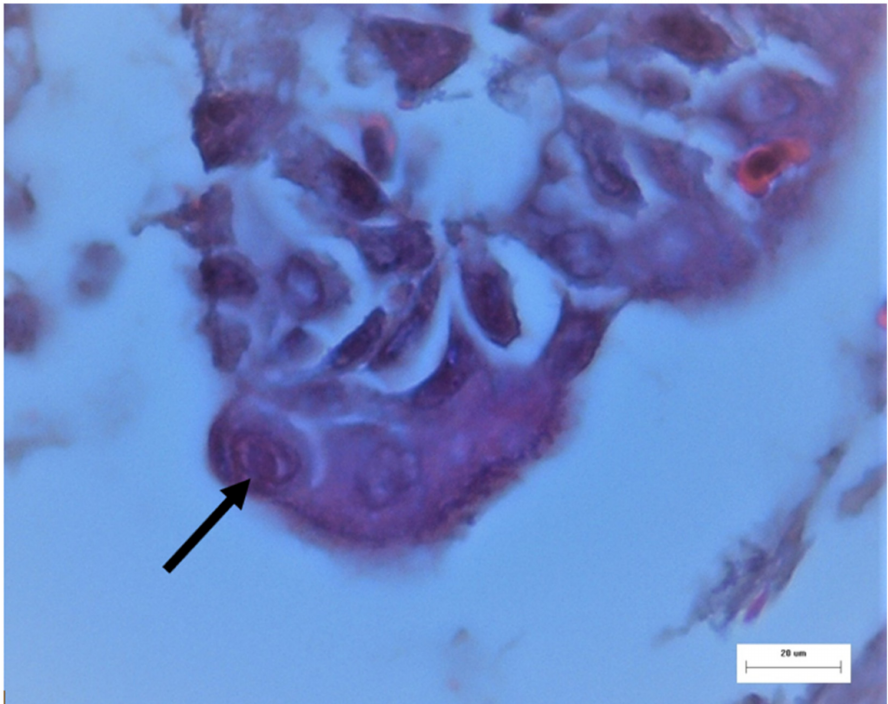
Figure 4. ILT, trachea from a broiler. Intranuclear viral inclusion body in an epithelial cell (arrow). H.E. stain; M: 400 ×